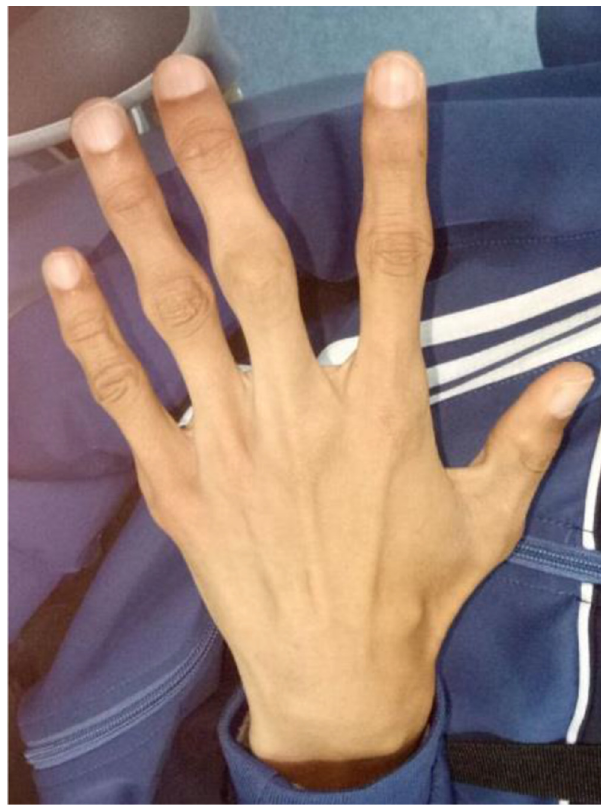
Fig. 3. Heterotopic ossi fi cations in the hand.